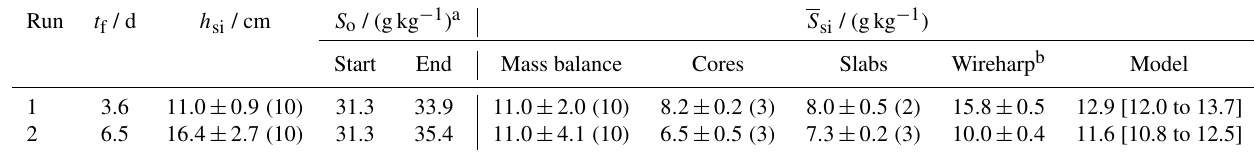
Table 4. Results for the mean bulk salinity, S si , calculated from five methodologies for two experimental runs. t f is the duration of the freezing period, and h si is the mean sea-ice thickness as measured in cores at the end of each run. The number of samples or profiles is given in brackets. With the exception of the model, all uncertainties are 1 standard deviation. Mass balance, core, and slab uncertainties were calculated based on repeat measurements. Wireharp uncertainties were calculated by propagation of the uncertainties on R 0 and θ for individual wire pairs. The model gives S si as predicted using the three parameter sets presented in Griewank and Notz (2015). Low bound: Ra c = 3 .